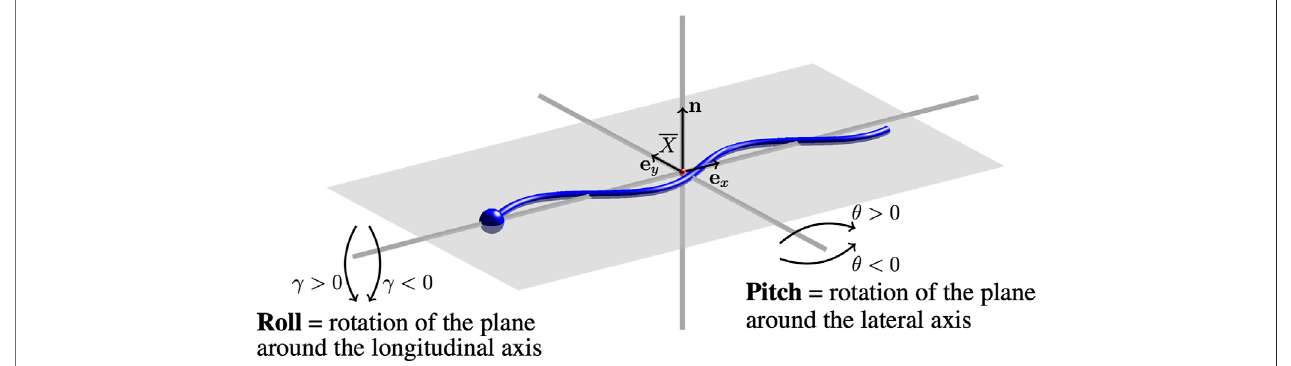
FIGURE 1 | Pitching and Rolling of Flagellar Beating Planes. A sketch of the swimmer (blue) and the beating plane (gray). Changes in the initial beating plane are characterized by a pitching angle θ and rolling angle c . The center of mass of the swimmer (cid:2) X is represented by a small red sphere at the origin. The normal vector to the beating plane is n , and e x and e y are the unitary vectors in the x and y direction, respectively. In this sketch, θ (cid:1) c (cid:1) 0 since the beating plane is in the plane z (cid:1) 0.